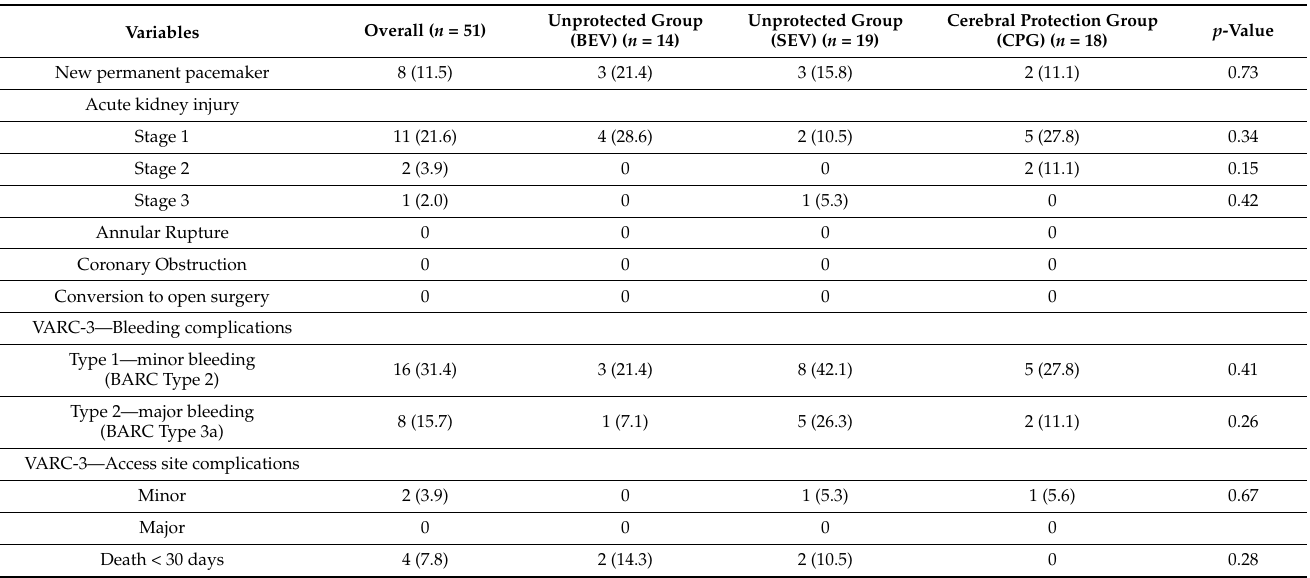
Table 3. Adverse